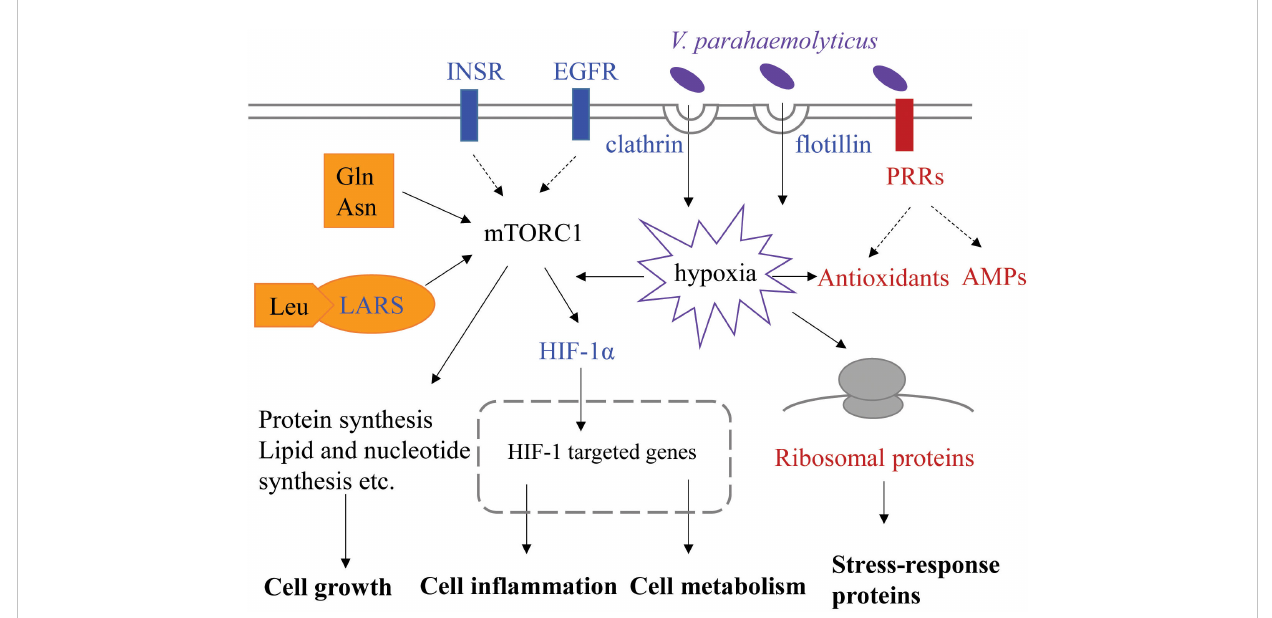
FIGURE 8 Putative key signaling pathways associated with resistance to VP AHPND involved in L. vannamei . This represents the cellular process of gill cells at 0 and 6 h post-infection. The upregulated genes in the susceptible or resistant family are shown in blue or red font, respectively. INSR, insulin-like peptide receptor; EGFR, epidermal growth factor receptor; LARS, leucine-tRNA ligase; PRR, pattern recognition receptor; AMP, antimicrobial